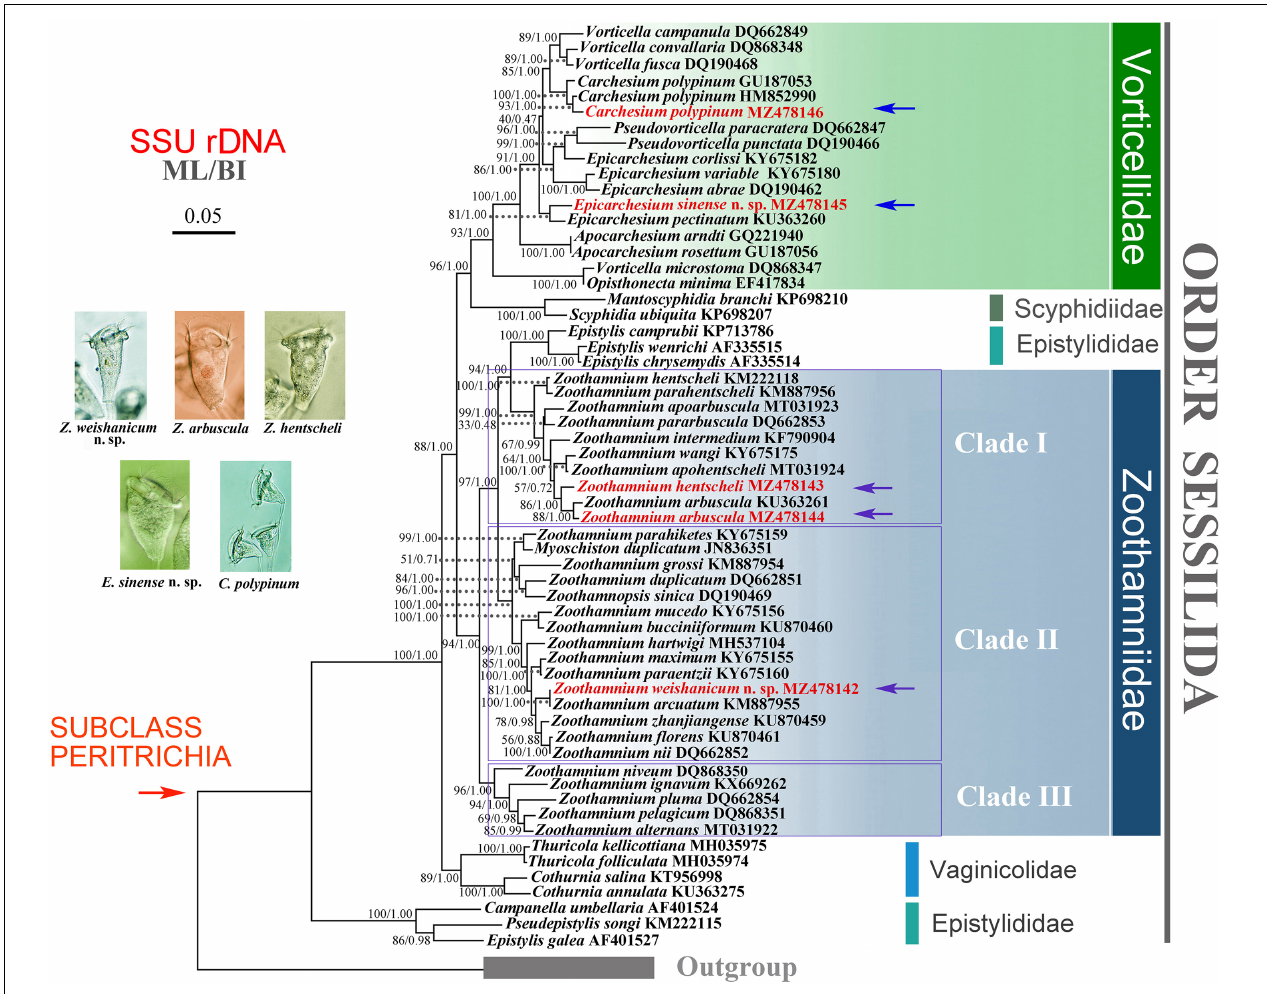
FIGURE 12 | Maximum likelihood (ML) tree inferred from SSU rDNA sequences, revealing the phylogenetic positions of Zoothamnium weishanicum n. sp., Z . arbuscula , Z. hentscheli , Epicarchesium sinense n. sp., and Carchesium polypinum (marked by arrows and red font). Numbers near the nodes denote maximum bootstrap values of ML out of 1,000 replicates and posterior probability of Bayesian inference. The scale bar indicates five substitutions per 100 nucleotide